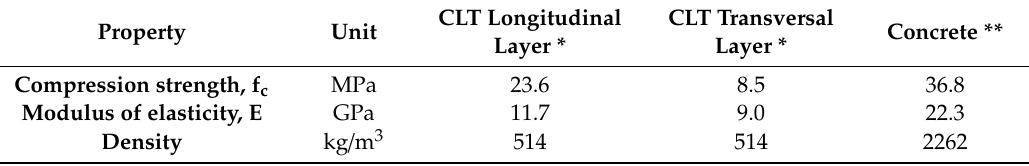
Table 1. Properties of CLT and concrete.